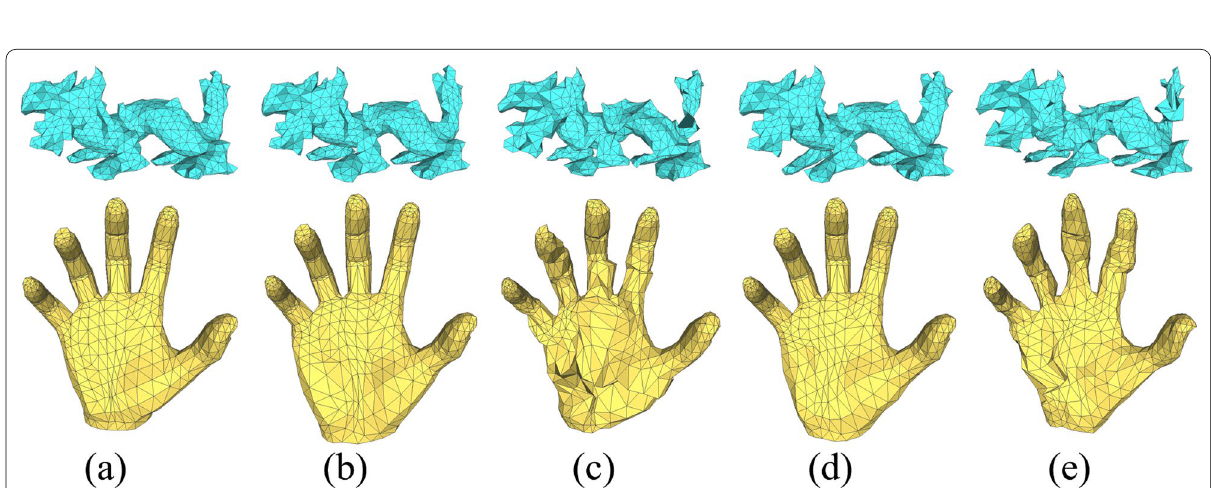
Fig. 8 The importance discussion of curvature consistency loss on Asiadragon (top) and Hand (bottom) dataset. a Original; b Proposed (w/ l cur ); c Proposed (w/o l cur ); d Proposed † (w/ l cur ); e Proposed † (w/o l cur